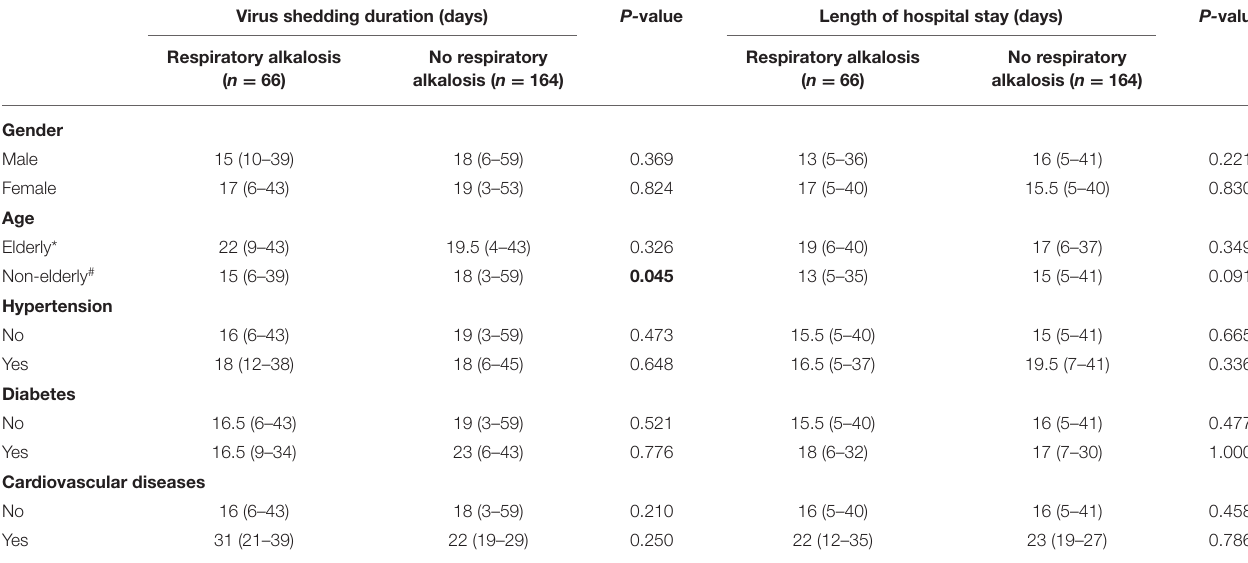
TABLE 4 | Subgroup analysis of influence of respiratory alkalosis on the virus shedding duration and length of hospital stay. Virus shedding duration (days)